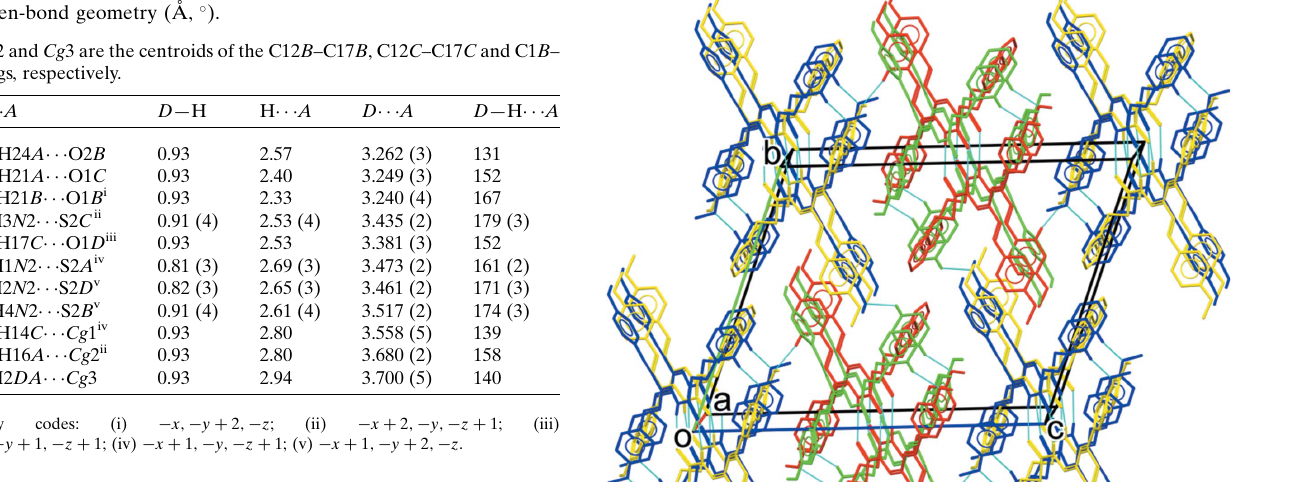
link the chains into a three-dimensional network, as shown in Fig. 5. Additional C—H (cid:3) (cid:3) (cid:3) (cid:2) interactions (Table 3) consolidate the packing.